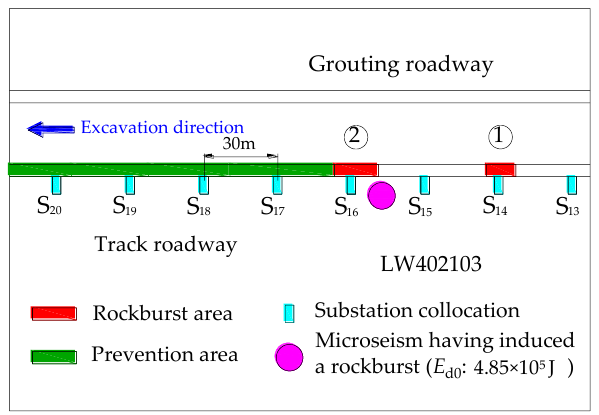
Figure 9. Rockburst and prevention of the track roadway in LW402103.